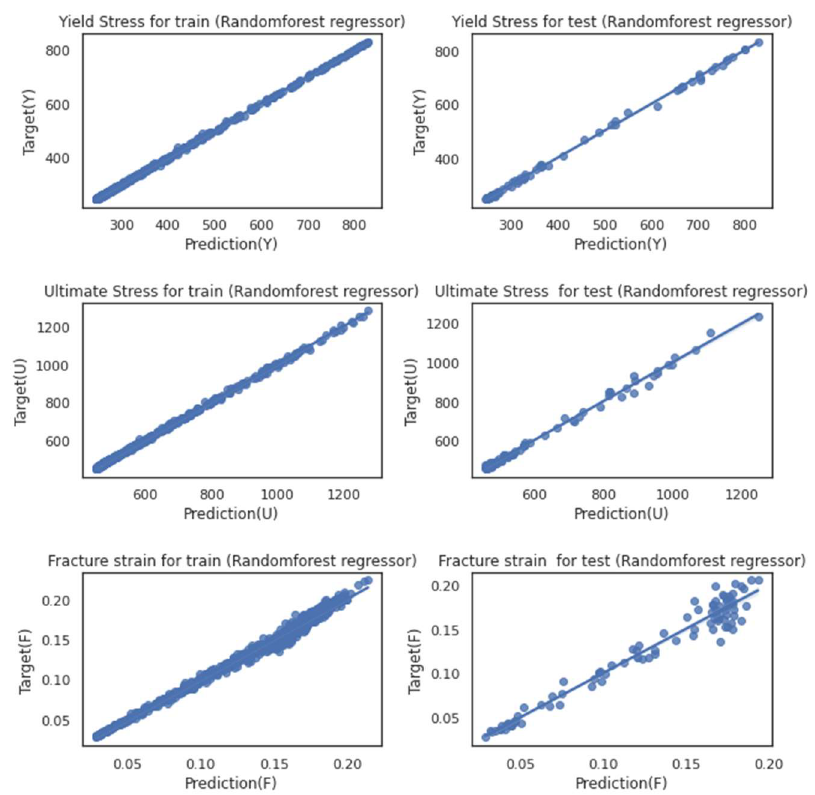
Figure 12. Scatter diagram of training and testing microstructure images while using the RF regressor for training (right figures) and testing (left figures) datasets for three mechanical properties: yield stress (Y), ultimate stress (U), fracture strain (F).